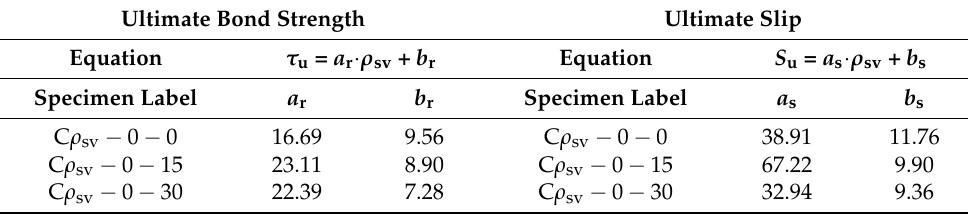
Table 8. The unified empirical formula.